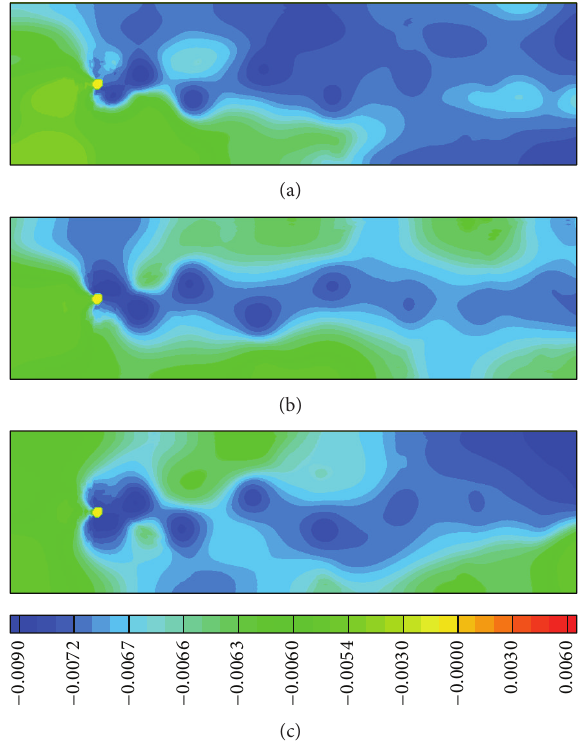
Figure 16: Distribution of free surface elevation with respect to a reference level (m); incise (a) at 350 seg, incise (b) at 400seg, and incise (c) at 450 seg of real time simulation.